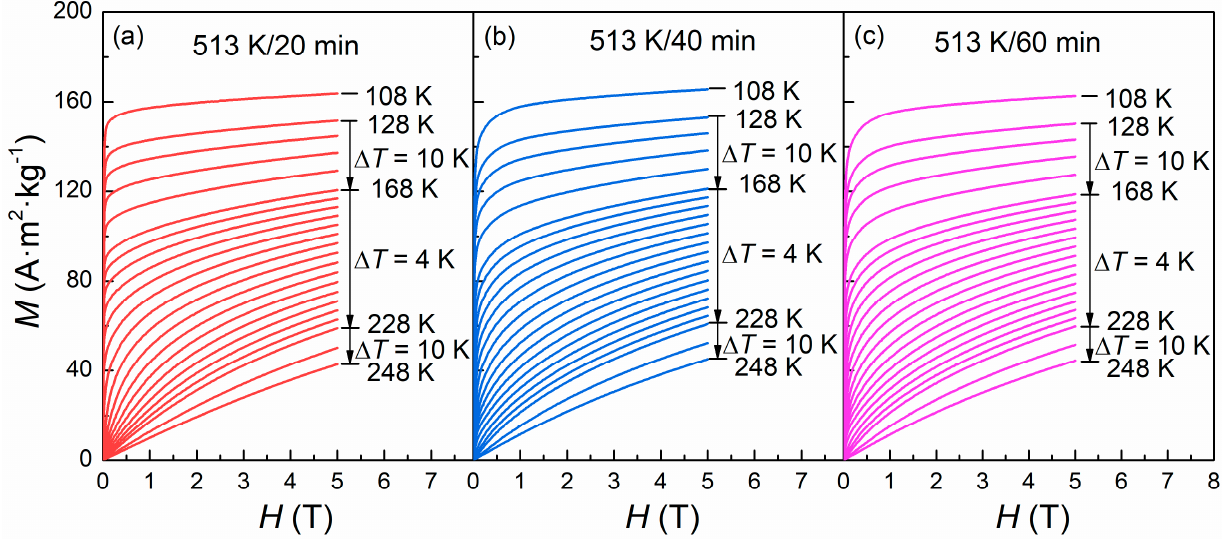
Figure 3. M - H isotherms of Gd 60 Co 40 amorphous ribbon after annealing at 513 K for ( a ) 20, ( b ) 40 and ( c ) 60 min under the Δ H of 0–5 T.